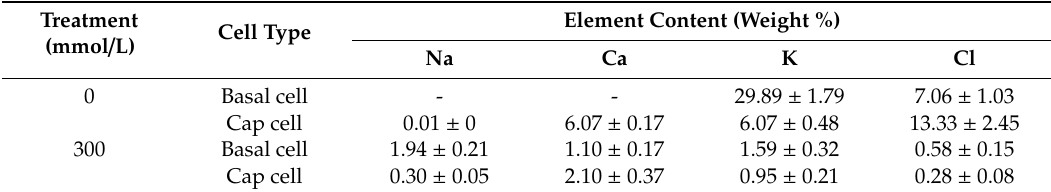
Table 1. Element (Na, Ca, K, Cl) content (weight %) of the salt gland (basal cell and cap cell) in the control group and 300 mmol / L NaCl-treated group (24 h). Element content measured by X-ray energy spectrum. Results were presented as a percentage. Means ( ± SD) were calculated from three replications ( n = 3) for each group. -: represents undetected.